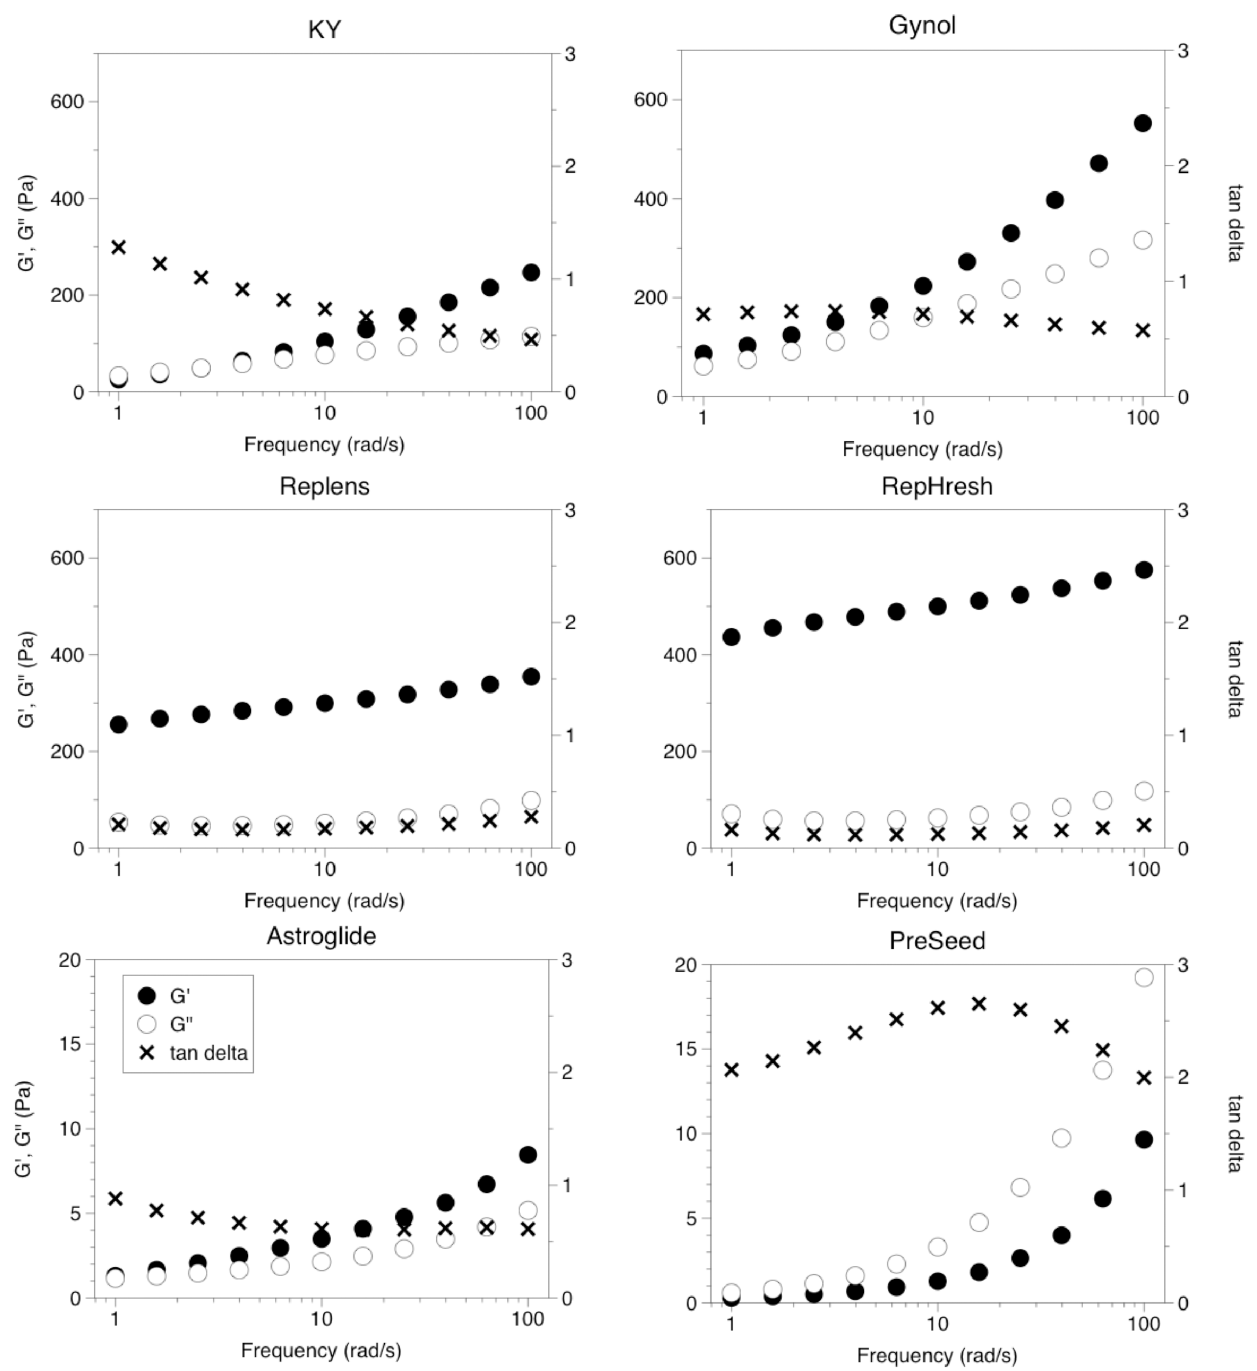
Figure 1. Multiple Factor Analysis plot of sensory and rheological data. Products are shown as squares. Rheological measures and sensory attributes are shown as vectors. The decat (DEscription of CATegories) function in the SensoMineR package for the R statistical environment was used to determine which of the variables within each sensory construct were most discriminating among the product set [30]. The final attributes selected showed more significant differences among products and thus were more capable of distinguishing products in terms of their corresponding underlying sensory constructs.